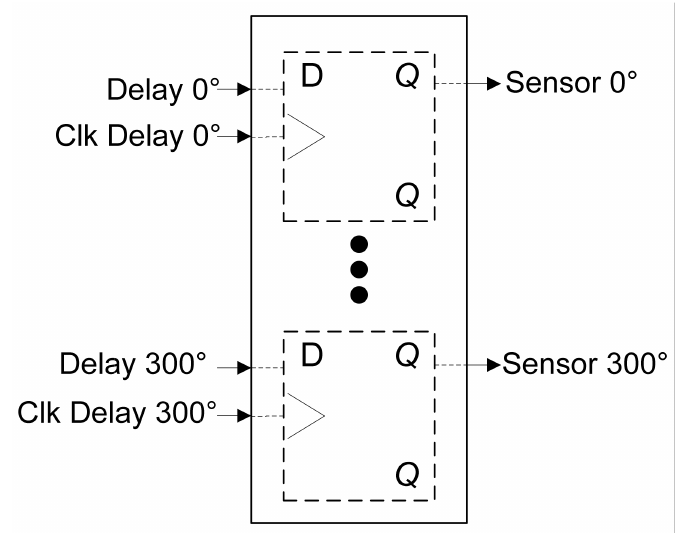
Figure 5. Phase shift detector module.